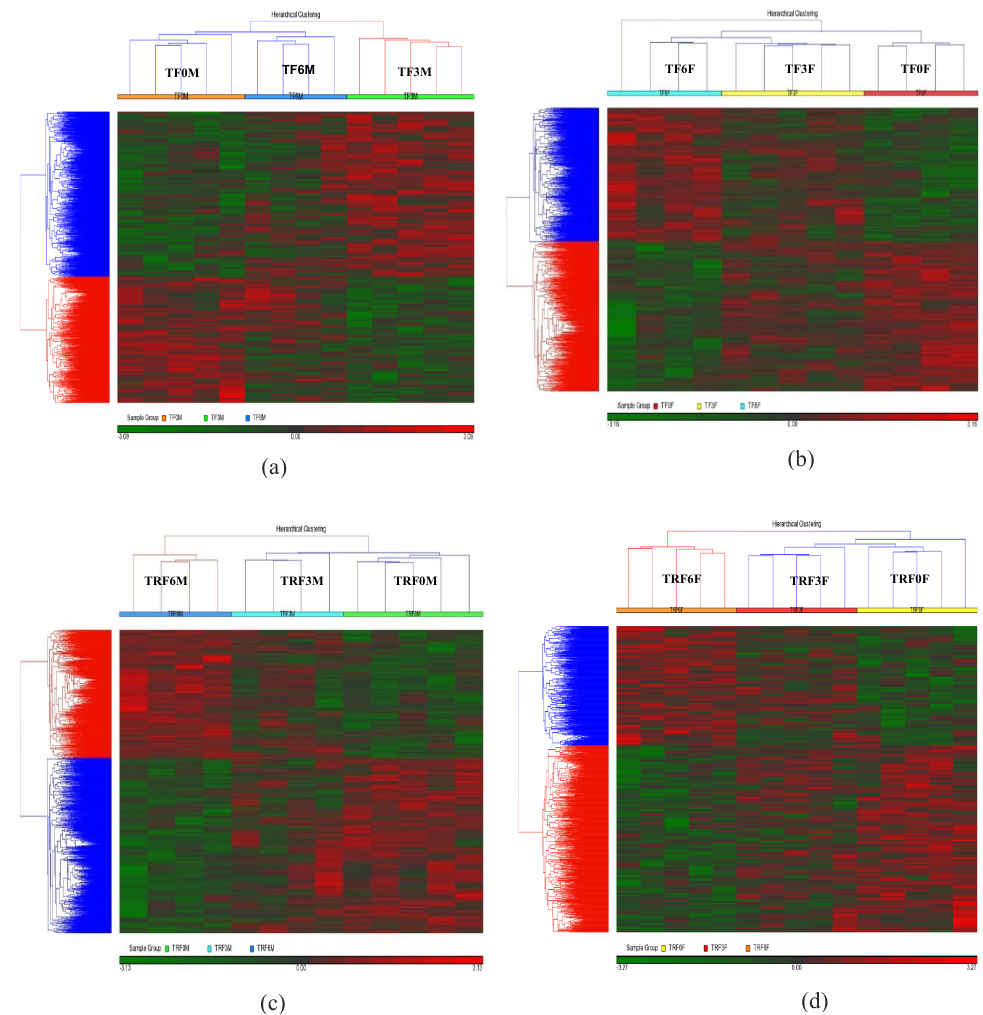
Figure 1 - Hierarchical clustering of α -TF and TRF supplementation. Similar gene expression profiles were joined to form a group. The expression profiles of the corresponding genes were considered to be significantly different at a fold change of ≥1.5 and p <0.05. Red indicates overexpressed genes, while green indicates inhibited genes. (a) α -TF supplementation in males after 3 and 6 months compared to 0 months. (b) α -TF supplementation in females after 3 and 6 months compared to 0 months. (c) TRF supplementation in males after 3 and 6 months compared to 0 months. (d) TRF supplementation in females after 3 and 6 months compared to 0